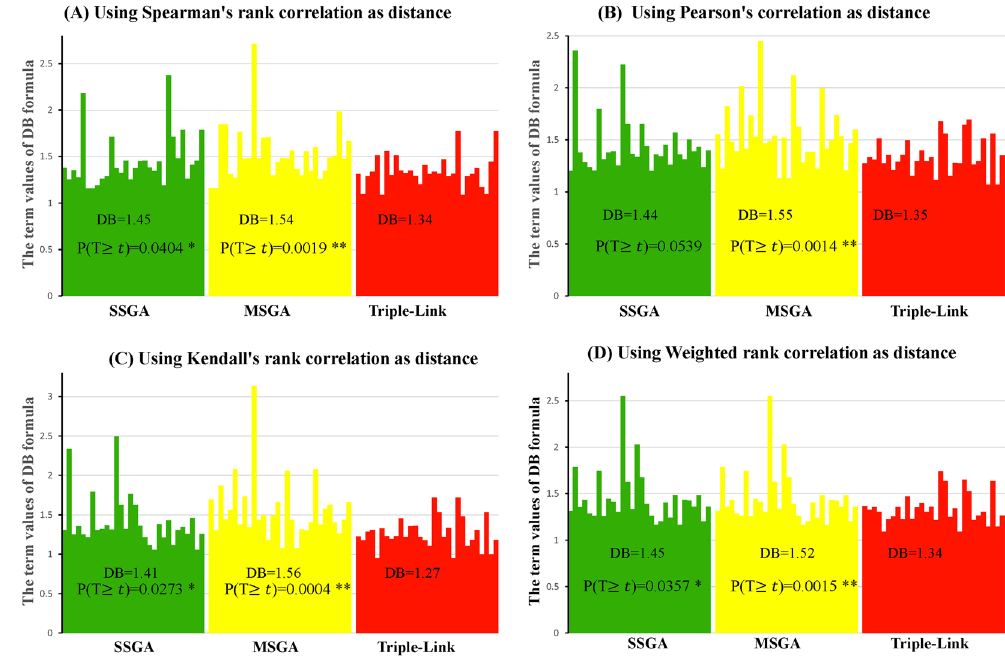
Figure 4. Davies-Bouldin (DB) indices for SSGA, MSGA and Triple-Link Algorithms, and the term scores of DB formula calculated for each of 30 subnetworks is represented by 30 bars. The distances used for calculating DB were based on Spearman’s rank correlation ( A ); Pearson correlation ( B ); Kendall’s rank correlation ( C ); Weighted rank correlation ( D ). In all the cases, the higher DB term scores or the DB indices, the tighter the internal coordination of derived subnetworks. The Student’s t-test (unpaired) was performed to examine the difference between DB’s term scores of 30 SSGA-/MSGA-derived subnetworks and DB’s 30 term scores of 30 Triple-Link Algorithm-derived subnetworks. The difference is significant if P( T ≥ t ) < 0.05